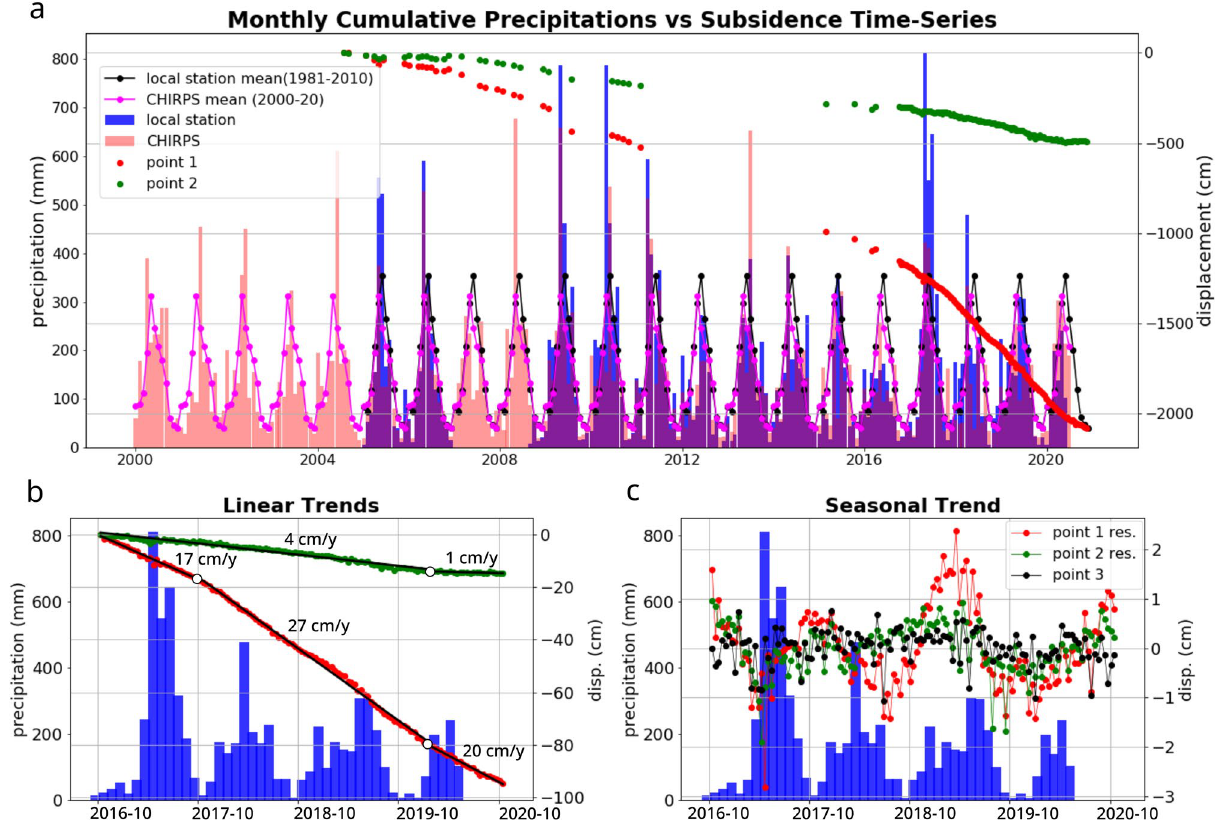
Figure 6. Long and short term vertical displacement time-series and local rainfall data. The location of the plotted points is shown in Fig. 2a. ( a ) 16-year long time-series: red (point 1) in the area of maximum displacement and green (point 2) in the minor subsiding region. Displacement values are on the right axis. Rainfall values are on the left axis: black dots and line for local station mean values; purple dots and lines for CHIRPS mean values; blue histogram for local station monthly cumulative precipitations; pink histogram for CHIRPS monthly cumulative precipitations. ( b ) 4-year short time-series for point 1 and 2 and histogram of local station monthly cumulative precipitations. Black-lines are the linear displacement interpolation representing the velocity trends; white dots shows changes in linear trend. ( c ) Seasonal trends: red and green dots of the residual estimated by subtracting a 3-grad polynomial trend from the displacement time-series for point 1 (point 1 res.) and point 2 (point 2 res.) respectively and black dots showing the displacement time-seires of point 3 in a potentially stable area. The figures were plotted using Matplotlib python library using InSAR time series and precipitation